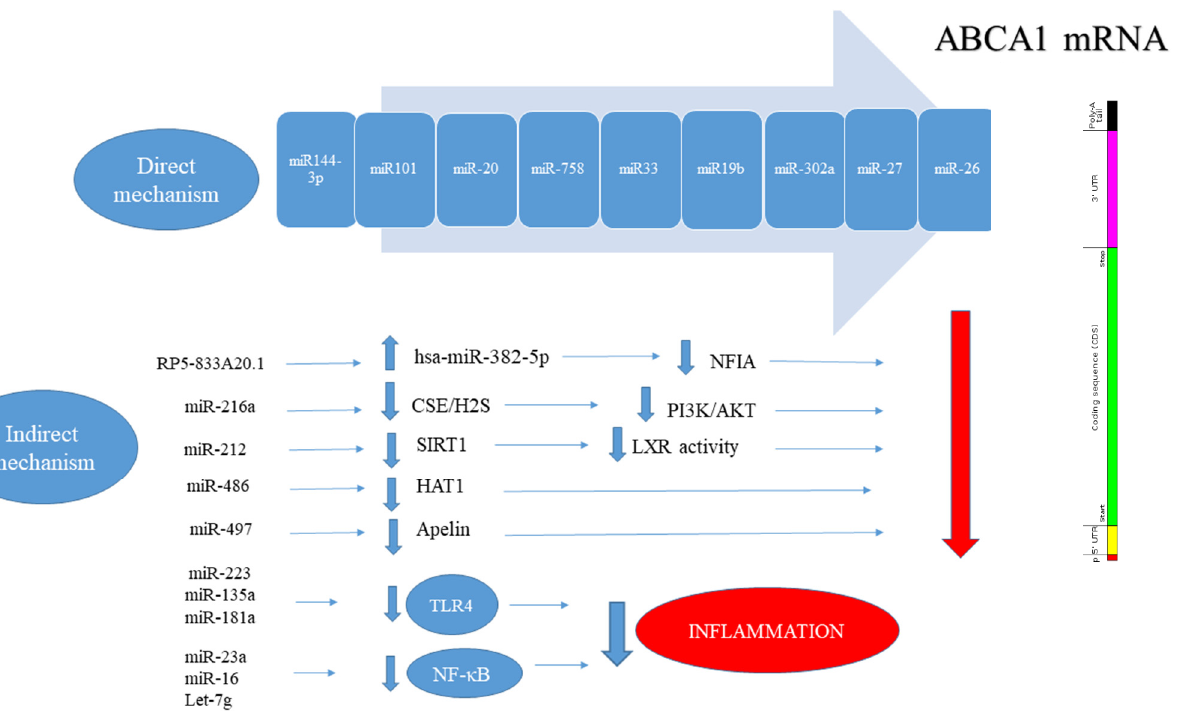
Figure 2. Direct and indirect effects of different Non-coding RNAs on the expression of ABCA1, which has a large 3UTR region and is one of the most important transporters in cholesterol efflux [144,145]. In direct mechanism: non-coding RNAs able to bind to 3' UTR of ABCA1 mRNA transcript which ABCA1 expression regulate, in indirect mechanism: non-coding RNAs were not able to bind to 3' UTR of ABCA1 mRNA transcript although these noncoding RNAs that bind to3' UTR of other mRNA transcript in turn regulate ABCA1 expression. It has also been shown that reducing inflammation increases the expression of this transporter and has a negative role in the formation of foam cells by increasing cholesterol efflux [148,149].